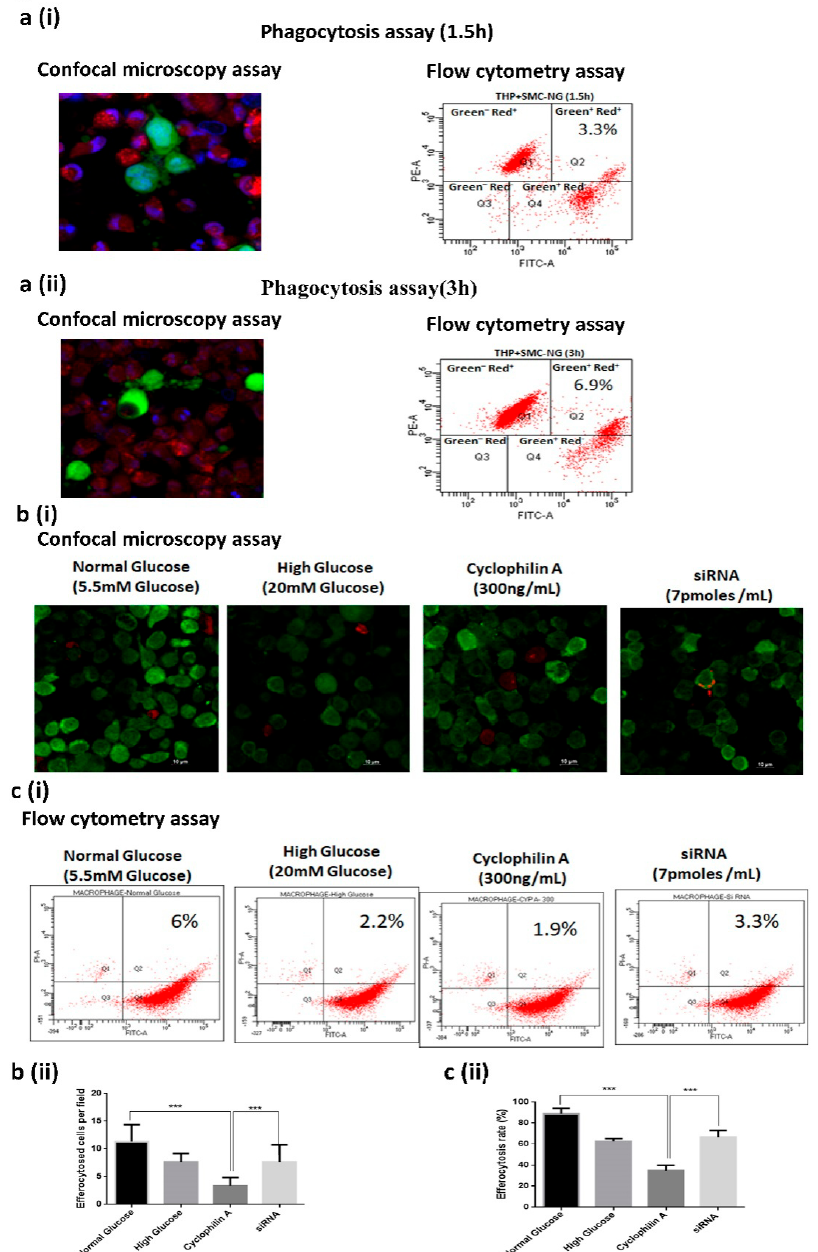
Figure 1. Cyclophilin A impairs efferocytosis of apoptotic macrophages: The effect of Cyp A on the efferocytic capacity of macrophages was determined by in vitro efferocytosis assay. ( a ) (i & ii). In vitro efferocytosis assay using confocal microscopy and flow cytometry assay at 1.5 h and 3 h post-treatment with CypA. ( b ) (i & ii). Confocal images, quantitative analysis of confocal images, ( c ) (i & ii). flow cytometry dot plots and efferocytosis rate of phagocytozed cells in the presence of CypA. Efferocytosis assay revealed that Cyp A-treated macrophages had a higher percentage of free cell-tracker green-stained apoptotic HCASMCs. Red-colored cells represent healthy phagocytes, and dual-positive cells (both red and green) represent efficient phagocytosis. * p < 0.05, *** p < 0.001.